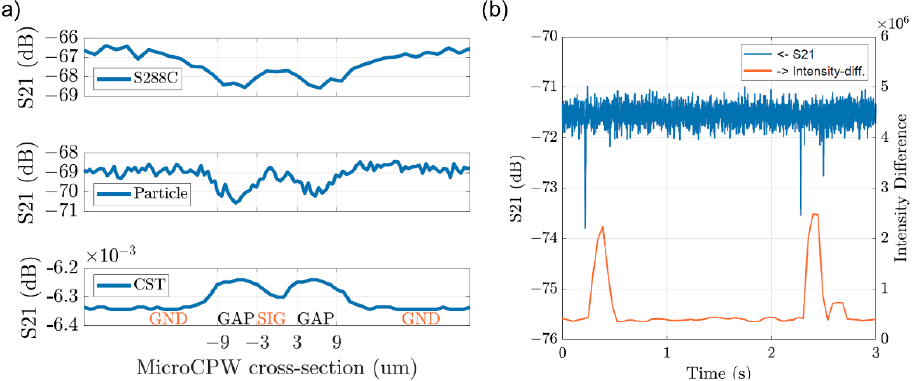
Figure 10. ( a ) The comparison of system S 21 signals between the single yeast cell of S288C, the solution of 3 um PSSs, and the simulated cubic particle in CST. ( b ) the optical correspondence with electrical detection using the intensity changes of the microscope images.